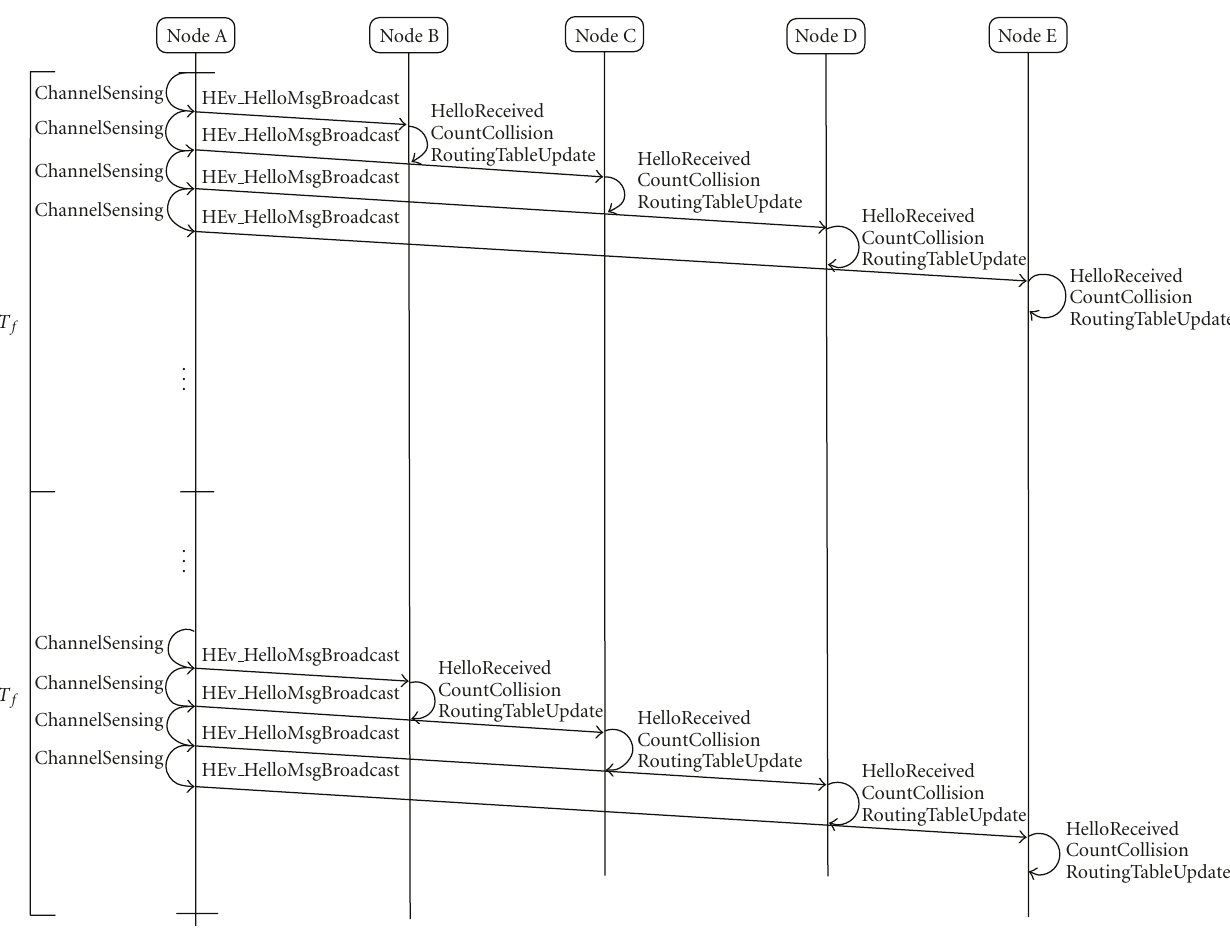
Figure 2: Message passing occurring within the discovery phase of the proposed D-STAR